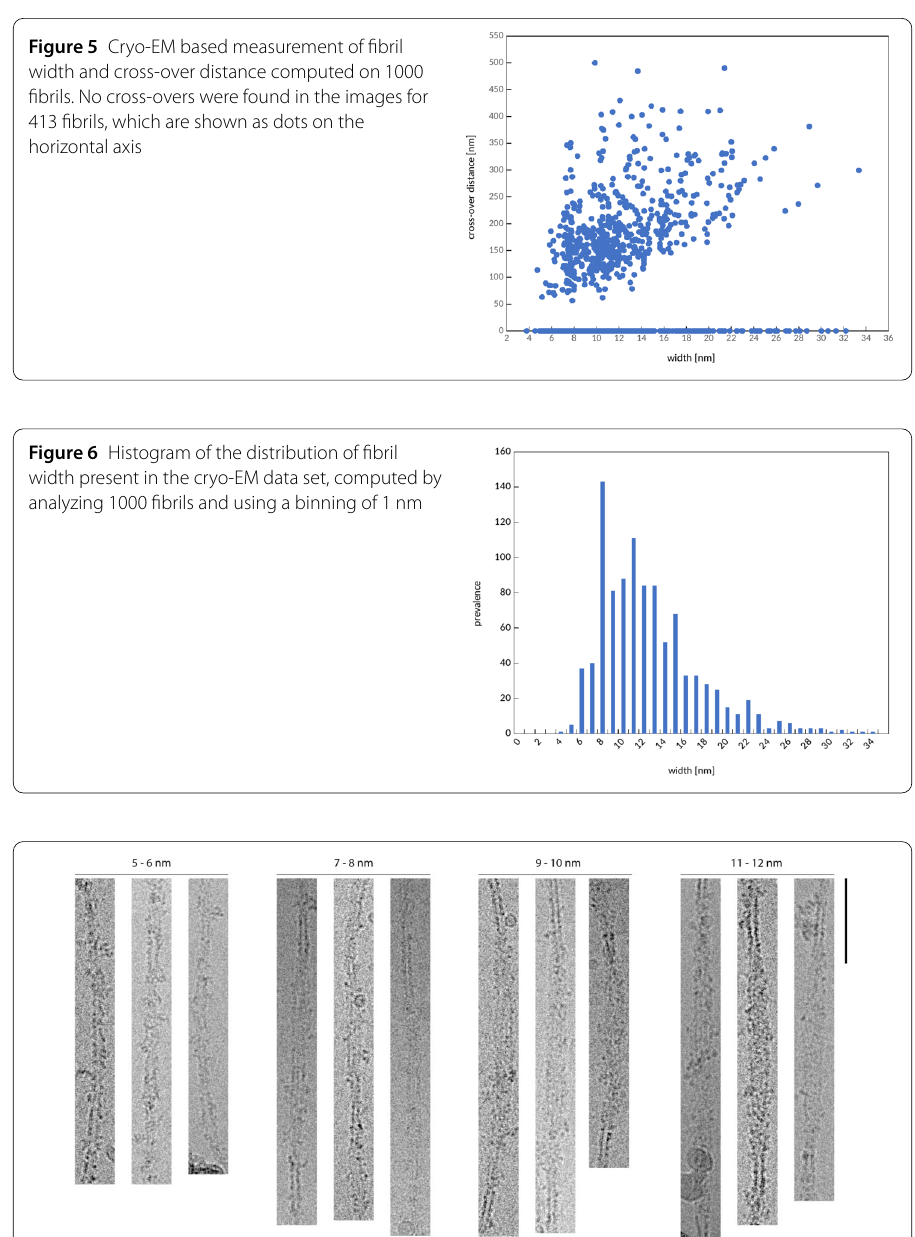
Figure 7 Cryo-EM images of fibril morphologies present in the data set. Scalebar: 50 nm